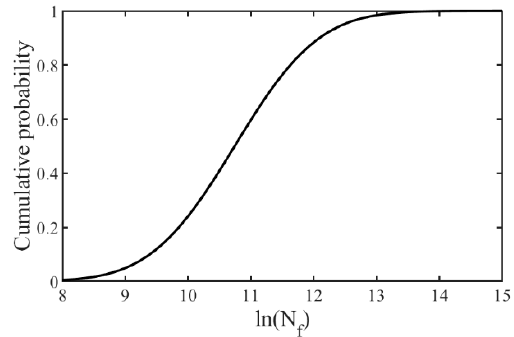
Figure 11. Cumulative probability distribution of predicted life.